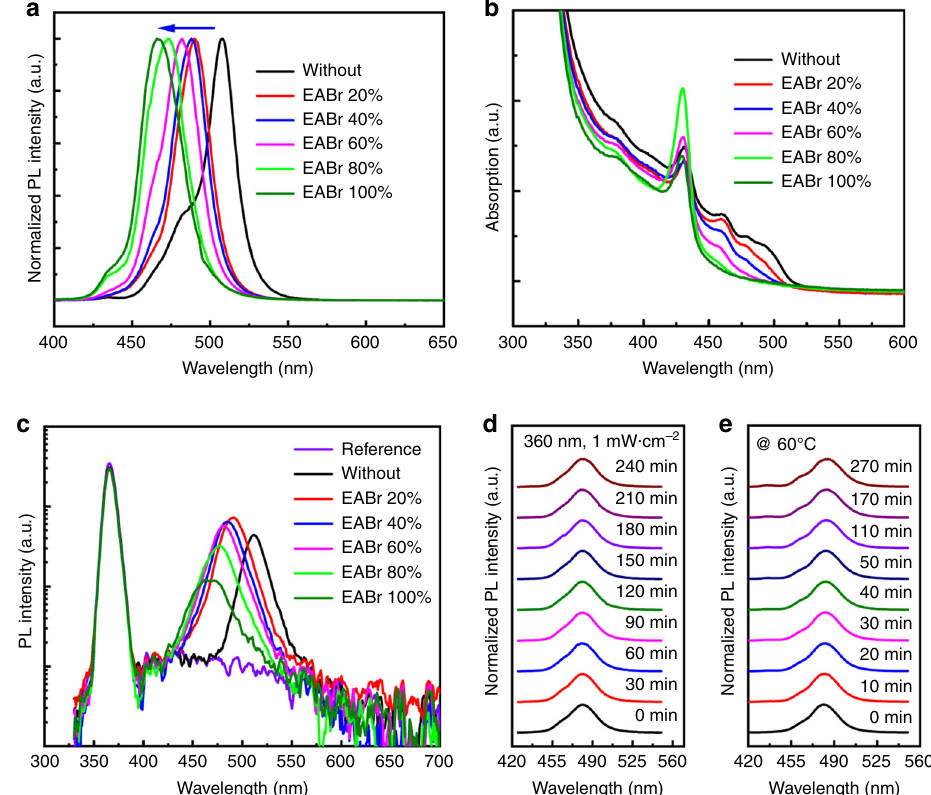
Fig. 1 Characteristics of perovskite fi lms with different EABr. a Normalized steady photoluminescence (PL) spectra. b UV – vis absorption spectra, and c Photoluminescence quantum yield (PLQY) spectra. d Normalized PL spectra of quasi-2D perovskite fi lm with 60% EABr under continuous UV radiation (360 nm, 1 mW cm − 2 ) for different exposure times. e Normalized PL spectra of quasi-2D perovskite fi lm with 60% EABr after continuous thermal treatment (60 °C) for different